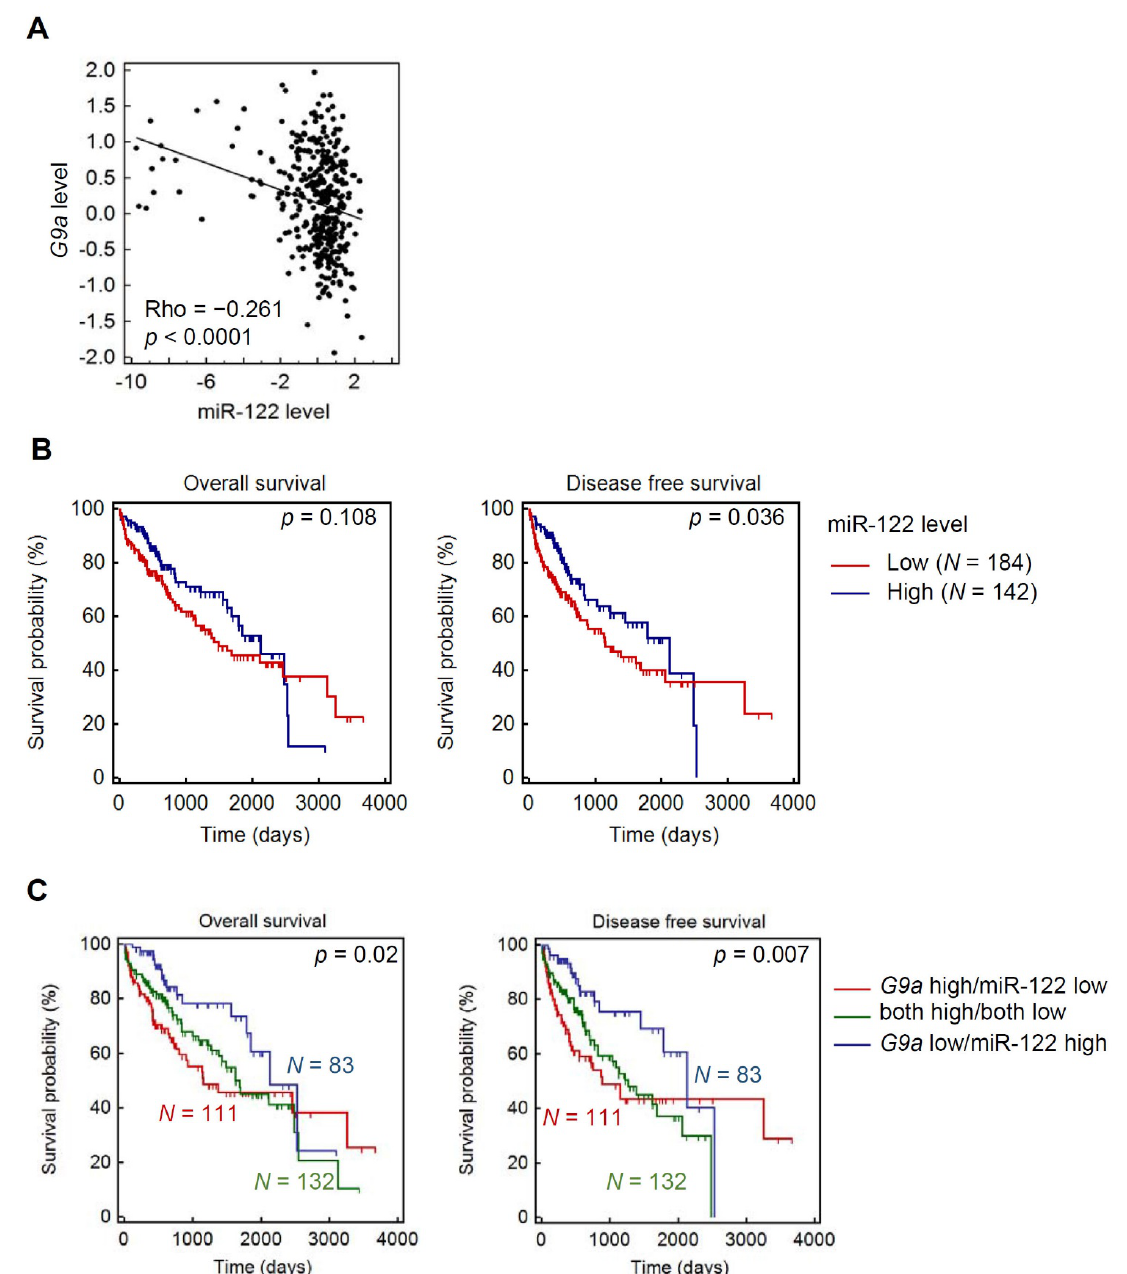
Figure 6. Clinical significance of miR-122 and G9a in hepatocellular carcinoma (HCC). ( A ) RNA expression scatter diagrams of G9a mRNA versus miR-122. Black dots represent expression levels of both genes from specimens in TCGA HCC dataset. Spearman’s non-parametric correlation test showing a negative correlation between G9a and miR-122 in HCC (Rho = −0.261, p < 0.0001). ( B ) Kaplan–Meier curves for overall survival (OS) and disease-free survival (DFS) of patients with HCC, as categorized according to high or low expression levels of miR-122. The p -value indicates a comparison between patients with miR-122 high and miR-122 low . ( C ) All HCC patients were separated into a negative correlation of G9a and miR-122 expression, low miR-122 and high G9a, and high miR-122 and low G9a, and others (both high/both low). Data showed that patients in the G9a high /miR-122 low group had the most favorable prognosis, including both OS and DFS.